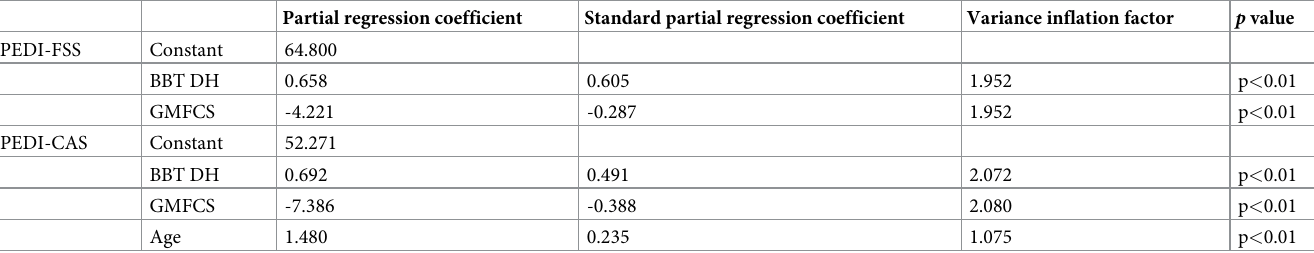
Table 3. Results of the multiple regression analyses for the PEDI-FSS and the